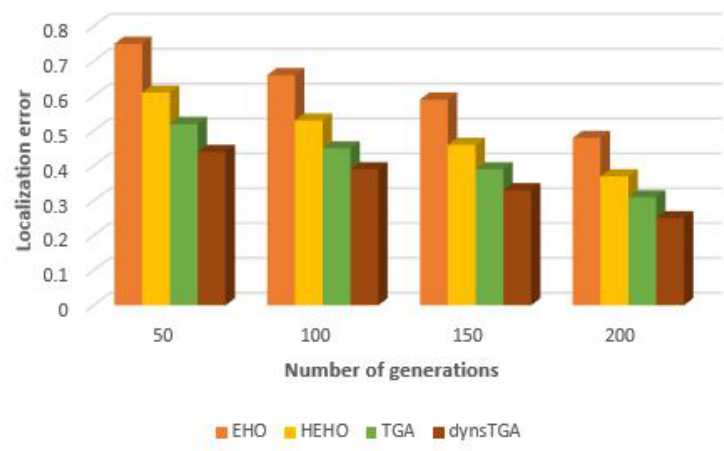
Figure 11. Localization error vs. number of